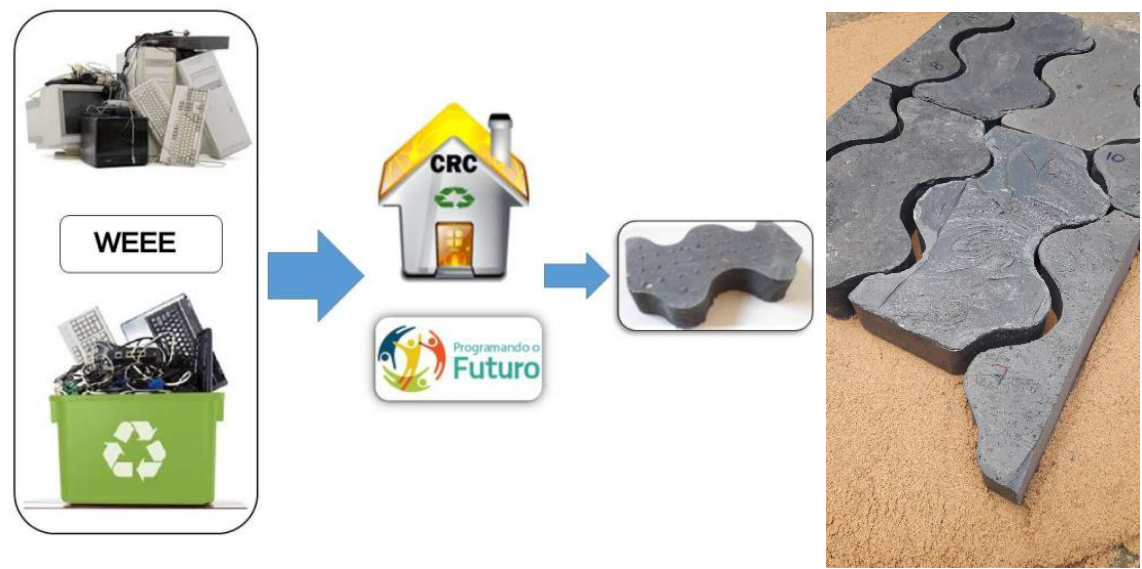
Figure 1. ( left ) From e-waste to interlocking plastic pavers: the recycling way. Containers to collect e-waste are distributed in strategic points (malls, supermarkets etc.). The Computer Reconditioning Centers (CRC) also collects electronic equipment either in public or private institutions. ( right ) On a sand bed, the pavers form a pavement with space for accommodation and drainage.